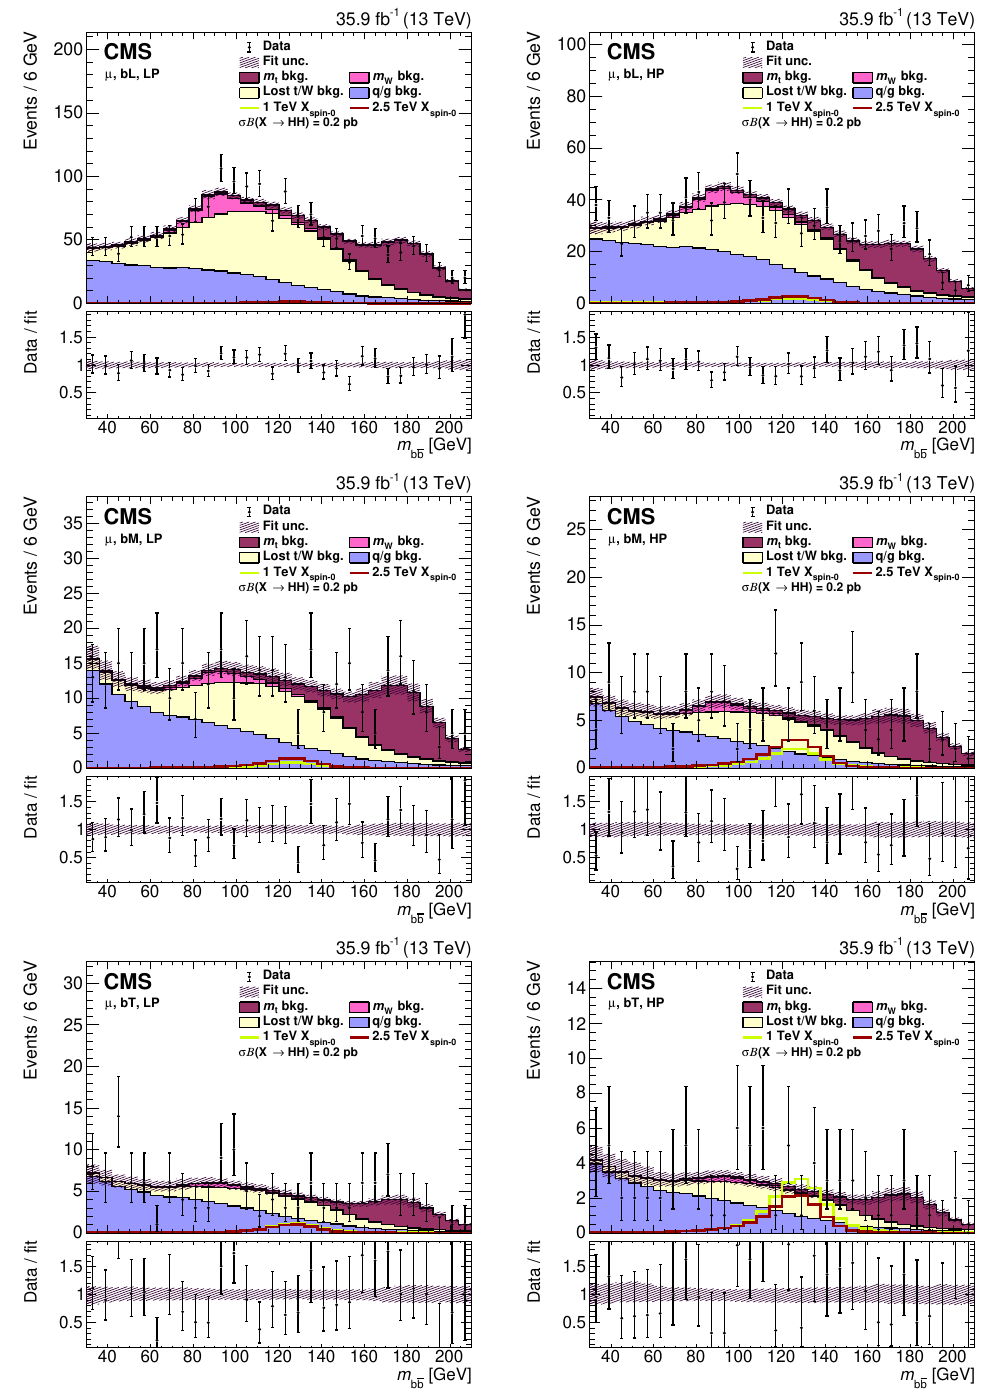
Figure 4 . The (cid:12)t result compared to data projected in m for the muon event categories. The bb (cid:12)t result is the (cid:12)lled histogram, with the di(cid:11)erent colors indicating di(cid:11)erent background categories. The background shape uncertainty is shown as the hatched band. Example spin-0 signal distribu- tions for m of 1 and 2.5 TeV are shown as solid lines, with the product of the cross section and X branching fraction to two Higgs bosons set to 0.2 pb. The lower panels show the ratio of the data to the (cid:12)t